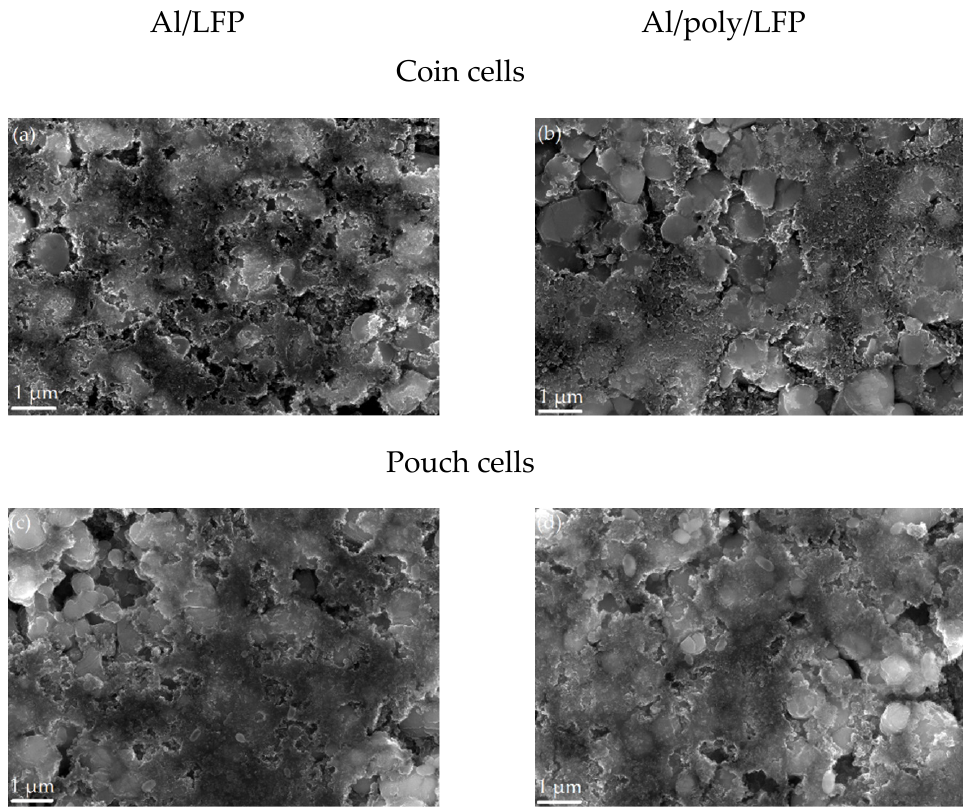
Figure 9. SEM images of electrodes (the white bar corresponds to 1 µm scale) after short circuit in Al/LFP ( a , c ) and Al/poly/LFP ( b , d ) coin and pouch cells, respectively.